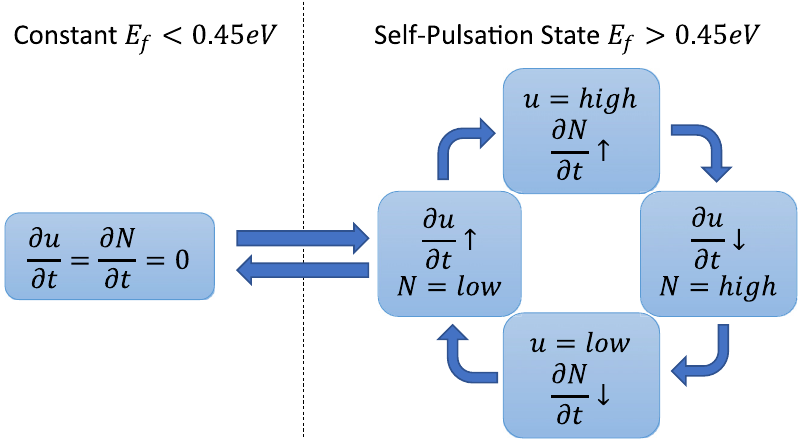
Figure 3: Flow chart of the self-pulsation behavior. The dotted line indicates the bifurcation between the constant state and the self-pulsation